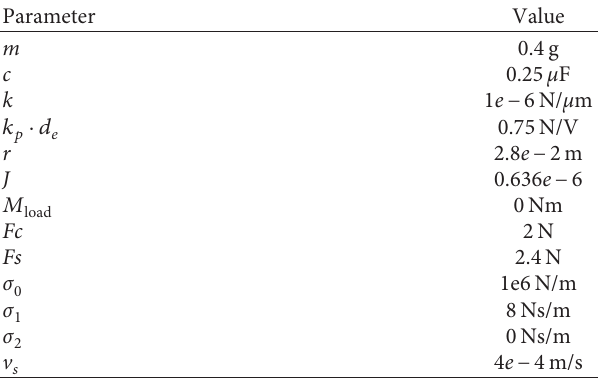
Table 1: Key parameters used in simulations.